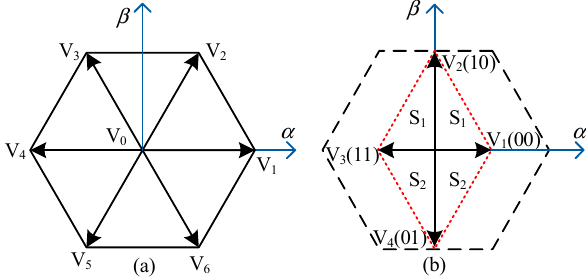
Figure 2. Space vector diagrams. ( a ) In normal mode. ( b ) In switch-open fault-tolerant mode.